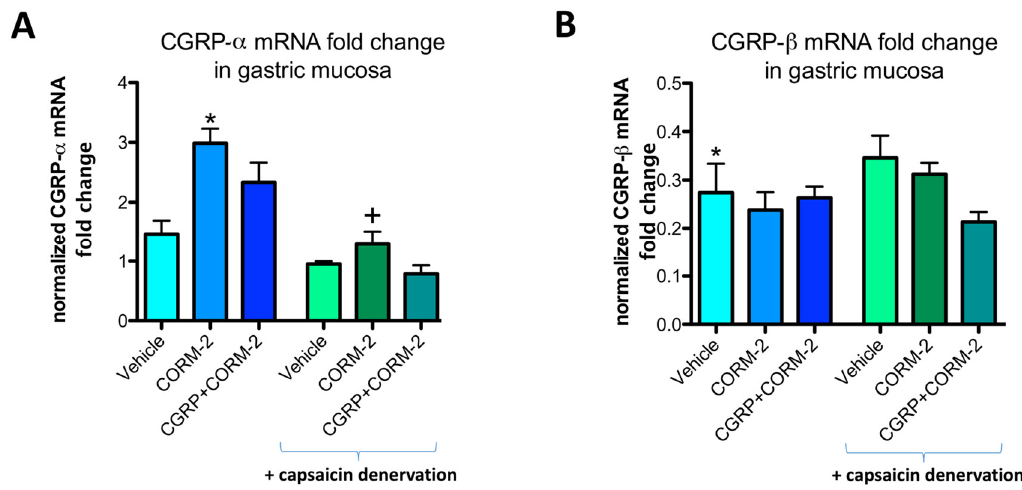
Figure 5. CGRP- α ( A ) and CGRP- β ( B ) mRNA fold change in gastric mucosa of rats with or without capsaicin denervation and pretreated with vehicle, CORM-2 (5 mg/kg i.g.) alone or in combination with exogenous CGRP- α (10 µ g/kg i.p.) and administered i.g. with 75% ethanol. Intact refers to healthy gastric mucosa. Results are expressed as mRNA fold change of CGRP- α or CGRP- β normalized to succinate dehydrogenase complex, subunit A (SDHA) and β -actin. Results are mean ± SEM. of 4–5 rats per group. ( A ) Asterisk indicates a significant change as compared with vehicle-control group without capsaicin denervation ( p < 0.05); cross indicates a significant change as compared with the group treated with CORM-2 without capsaicin-denervation. ( B ) Asterisk indicates significant change as compared with values obtained in intact gastric mucosa ( p < 0.05).